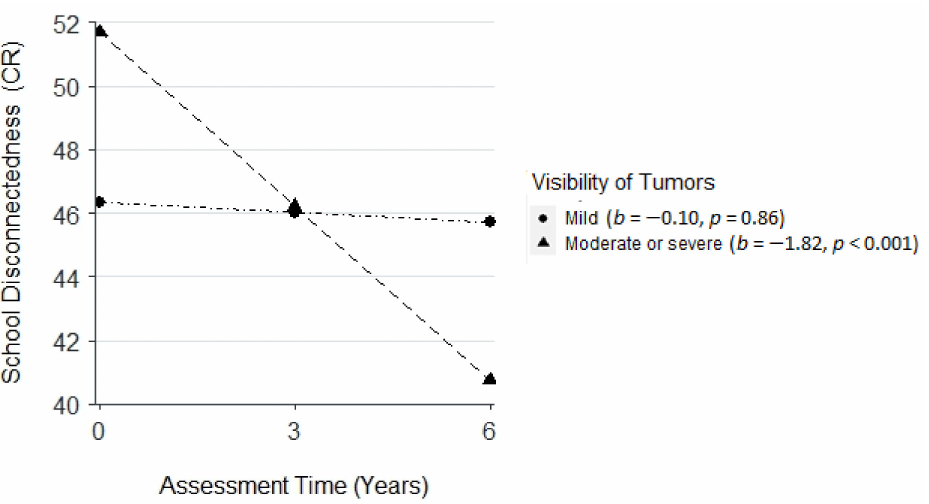
Figure 4. Plot for the interaction effect among assessment time and visibility of tumors on school disconnectedness (child-reported,